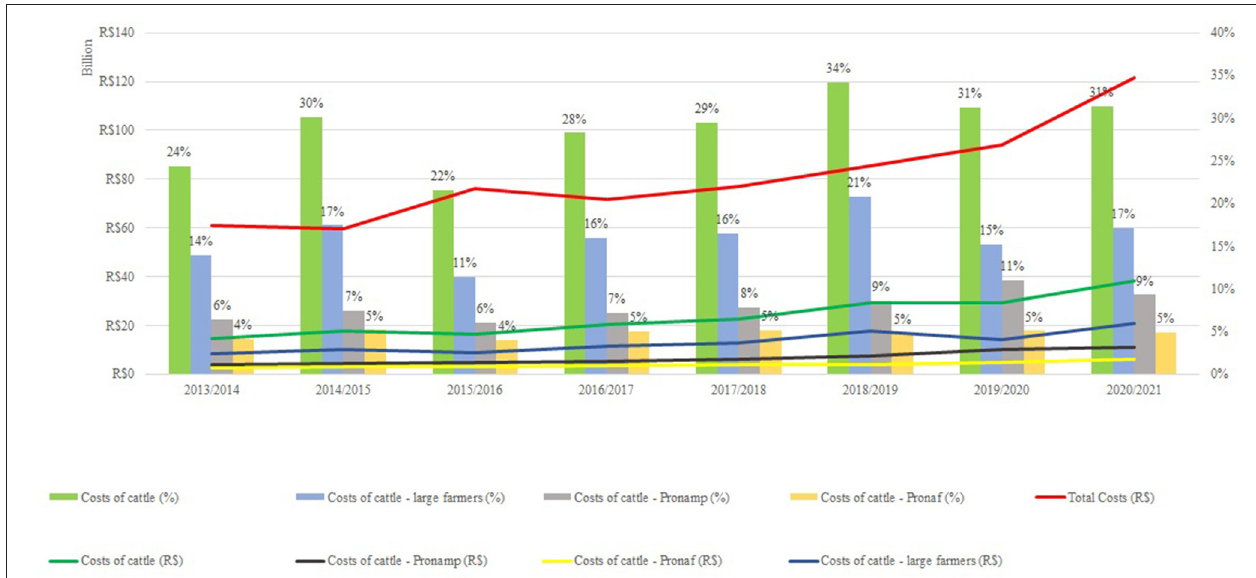
FIGURE 4 | Amount and percentage of rural credit applied to total operating costs, total operating costs of cattle, and operating costs applied to cattle of large, medium and family farmers from 2013 to 2021. Source: Prepared by the authors with data from BCB